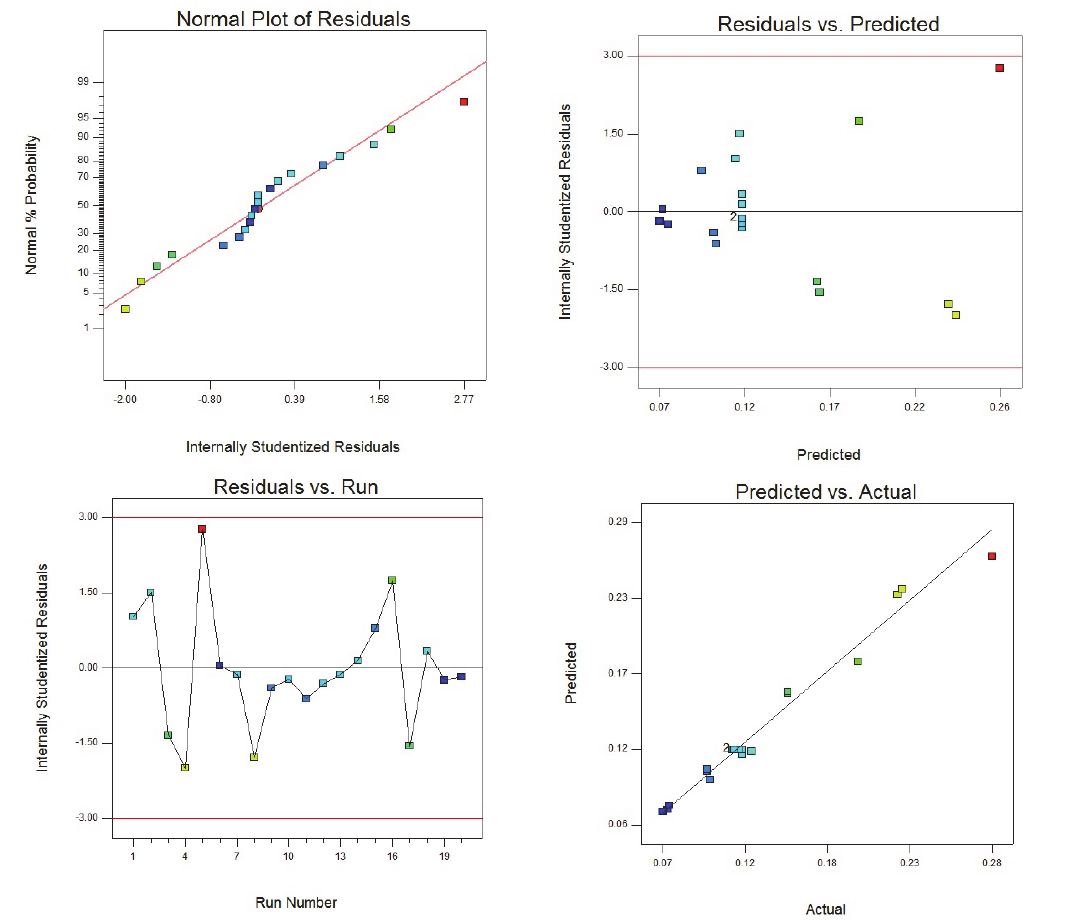
Fig. 8. Residual plots for tool wear of post turning composite